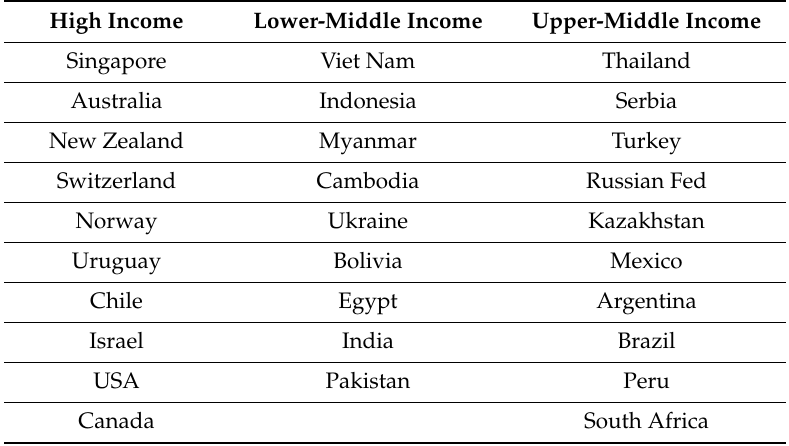
Table 7. Classification of countries by income